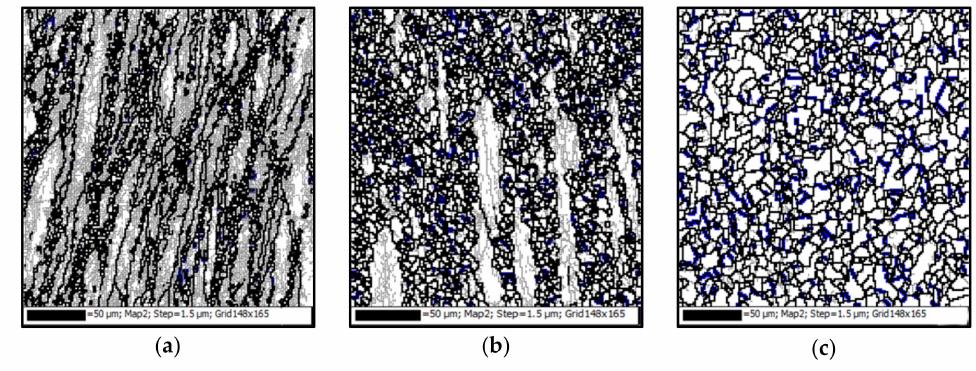
Figure 6. Evolution of annealing twins at the deformation temperatures of: ( a ) 1193 K; ( b ) 1253 K; ( c ) 1313 K (LAGBs, HAGBs and annealing twin boundaries are indicated by thin-gray, thick-black, and thick- blue lines, respectively. The strain and strain rate are 1.2 and 0.01 s − 1 ,